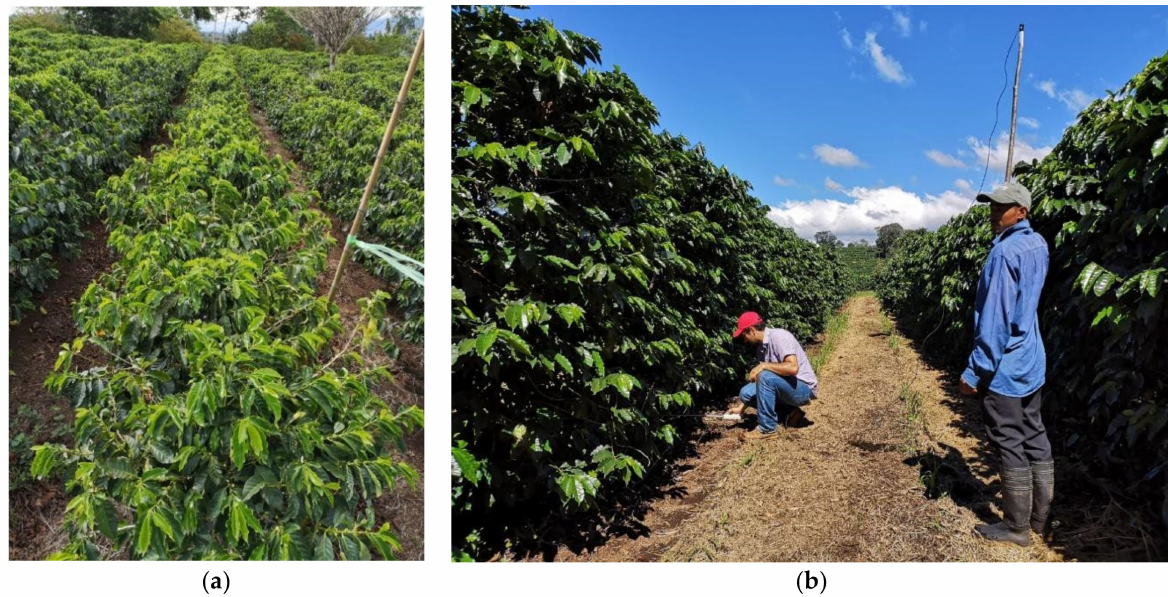
Figure 5. Views of sun-grown coffee fields exposed to full radiation at La Hilda (10.0893” N, 84.235088” W). ( a ) Coffee hedgerows were re-designed from spacings of 1.8 m between hedgerows and 1 m between plants (5555 plants/ha) to ( b ) 3.6 m between hedgerows and 0.8 m between plants (2777 plants/ha). In this innovative production system, emphasis is on hedgerow structure and functioning and the re-distribution of the leaf area index, with relatively less attention paid to individual coffee plants. The interrow space is planted with deep-rooted Brachiaria sp., which promotes soil and ecosystem